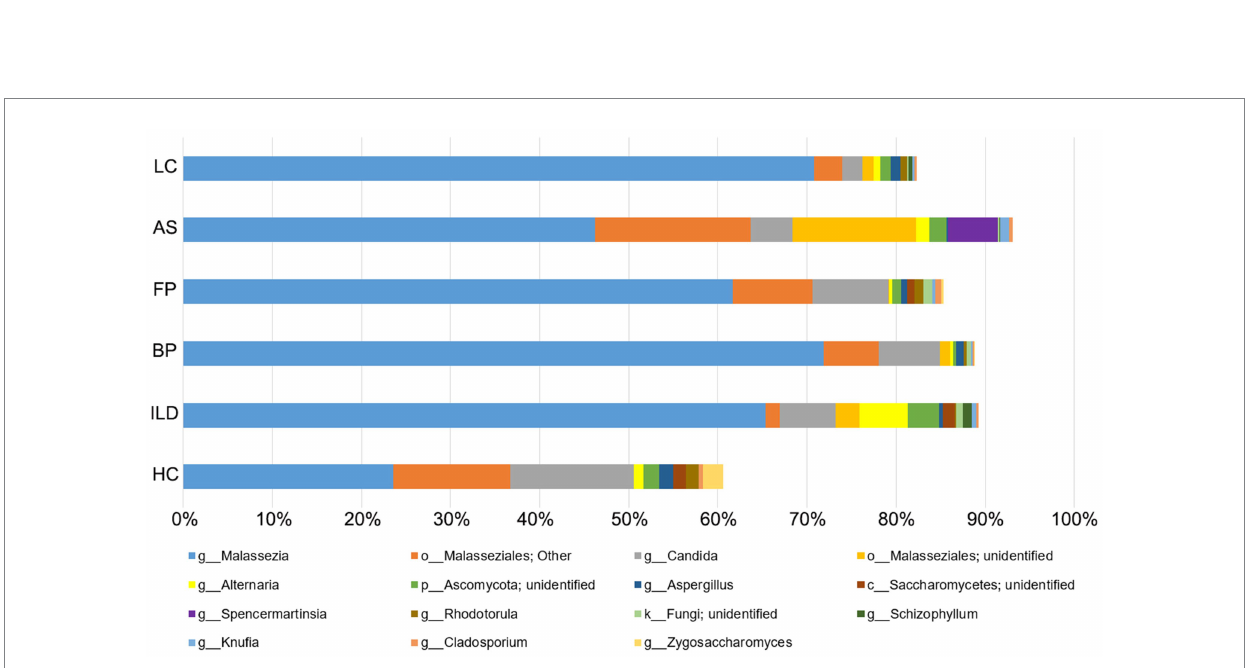
FIGURE 5 The relative abundance of the identified OTUs at the genus level in each group. The top 15 abundant OTUs on average in all the groups were